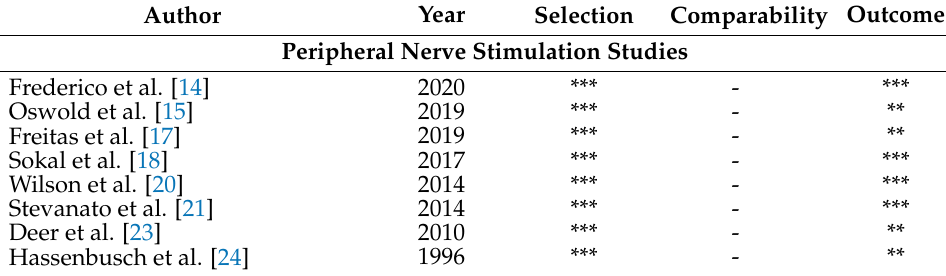
Table 2. Newcastle Ottawa risk assessment, table and